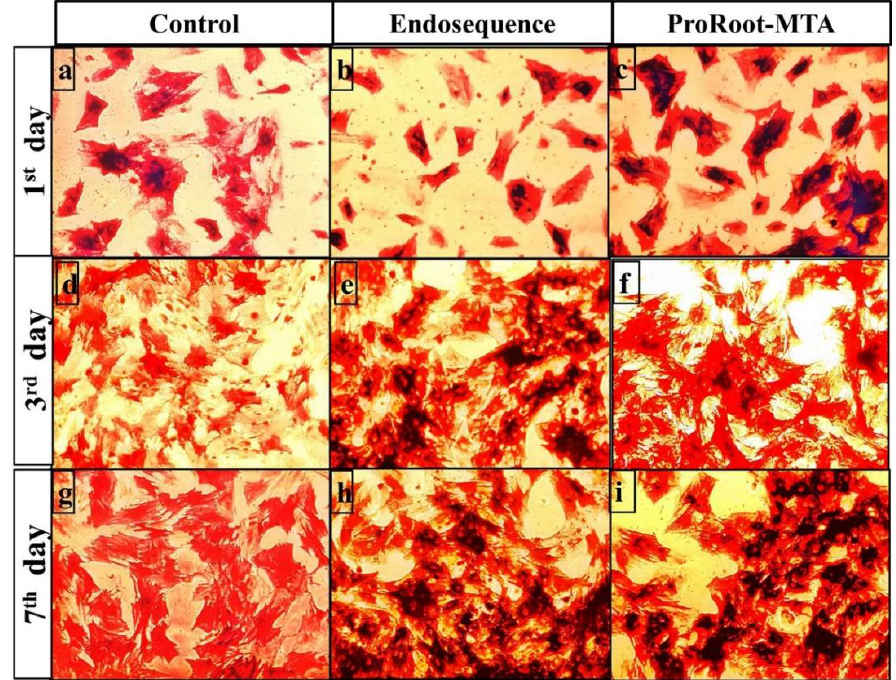
Figure 3. Photomicrographs of mesenchymal stem cells untreated and treated with either ERRM or ProRoot-MTA, stained with alkaline phosphatase staining on day one ( a – c ), day three ( d – f ) and day seven ( g – i ), respectively, at 20× magnification.